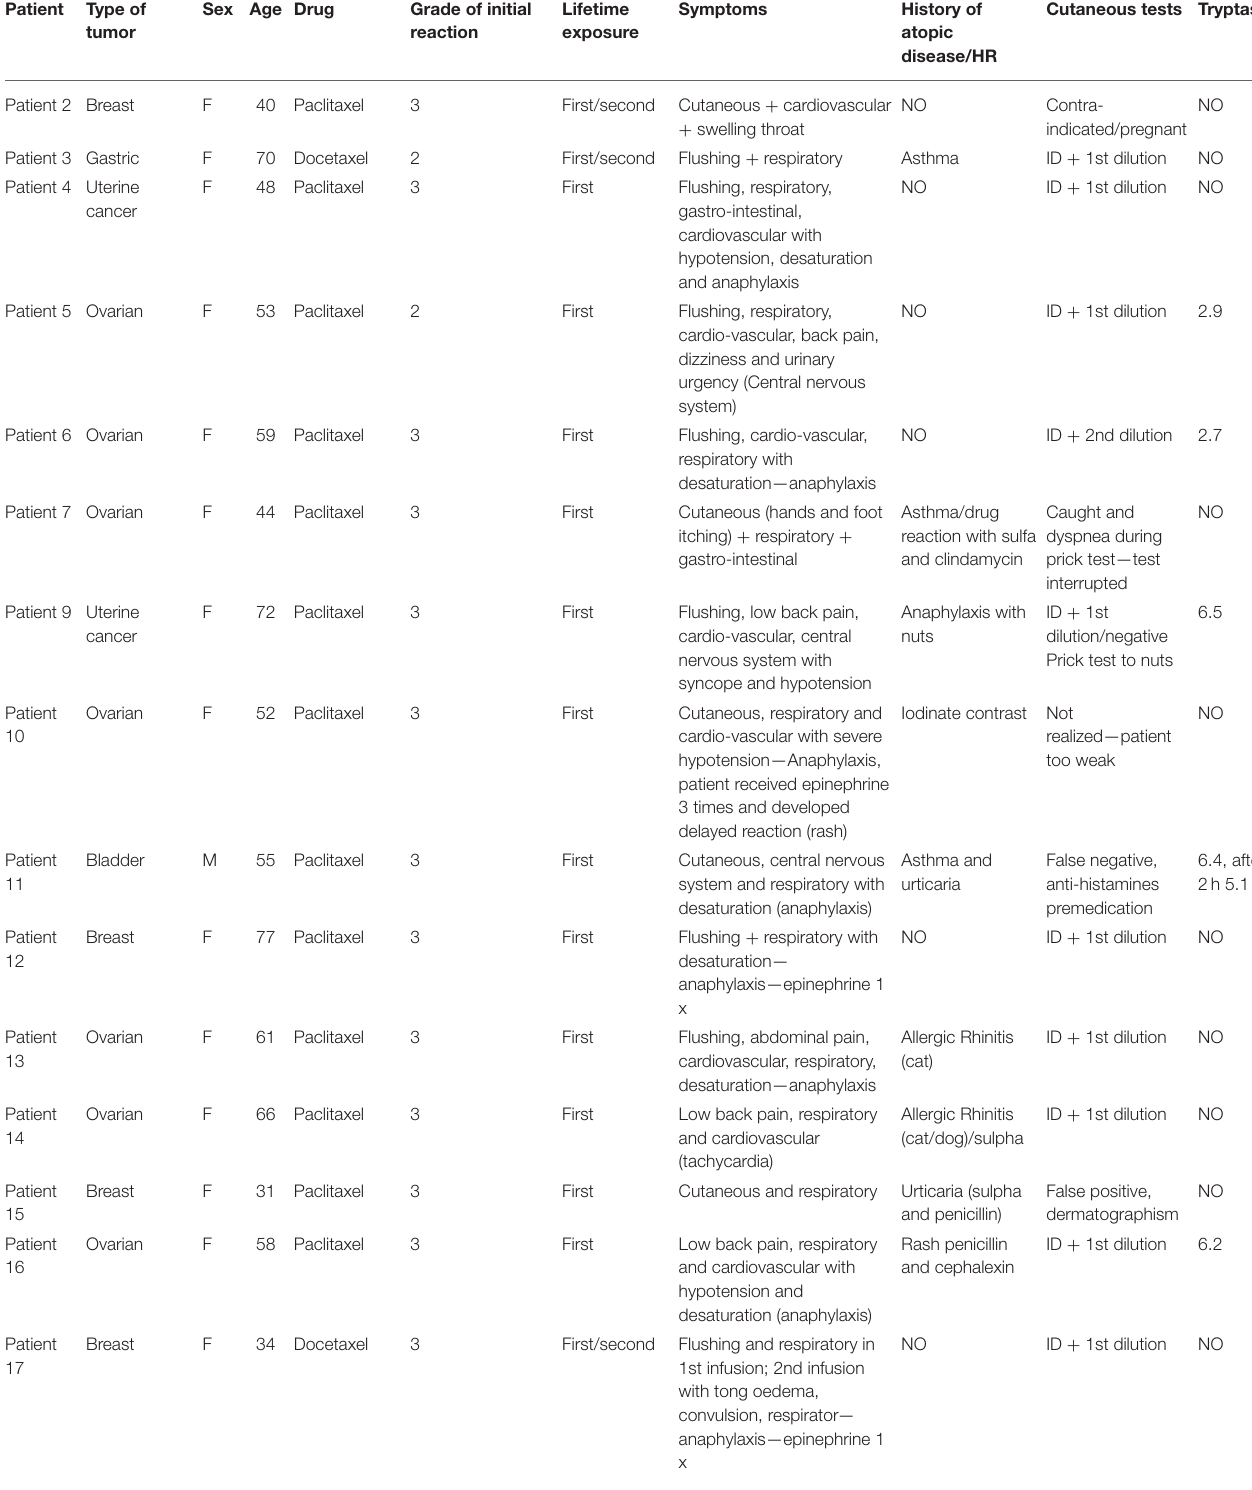
TABLE 1 | General characteristics of patients and hypersensitivity reactions to taxanes (patients # 1 and # 8 were excluded due to initial reaction grade 1). Patient Type of